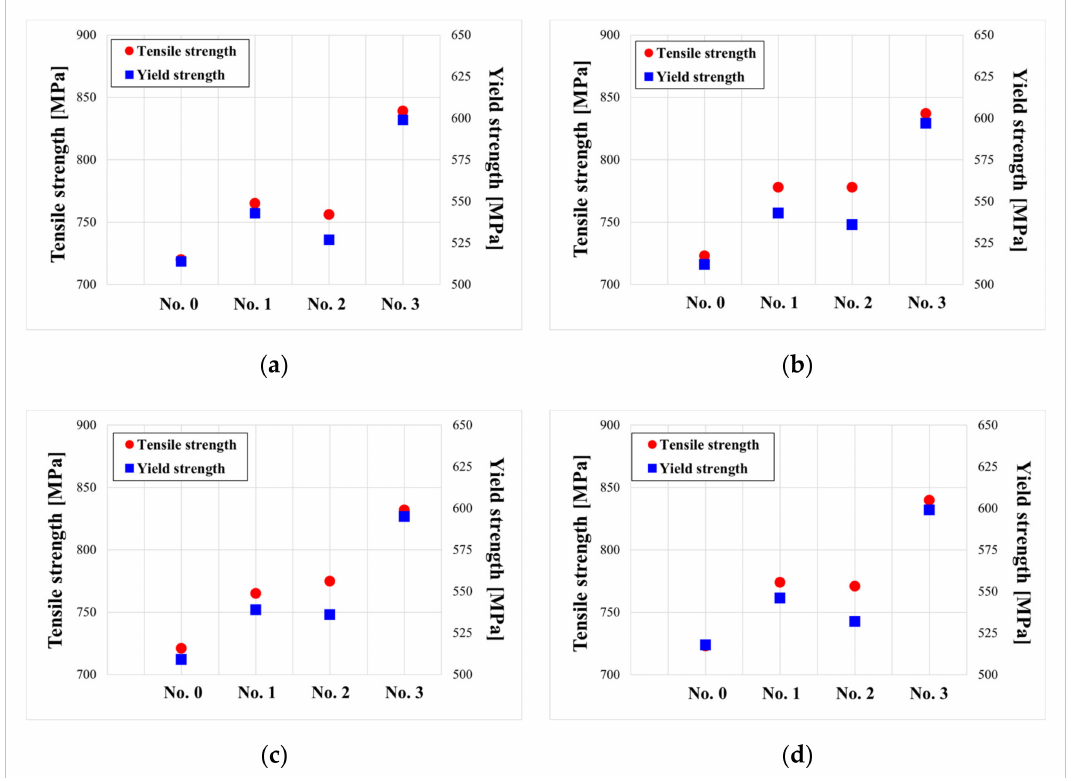
Figure 15. Tensile and yield strengths for the four specimens in the four directions shown in Figure 4: ( a ) 1, ( b ) 2, ( c ) 3, and ( d )